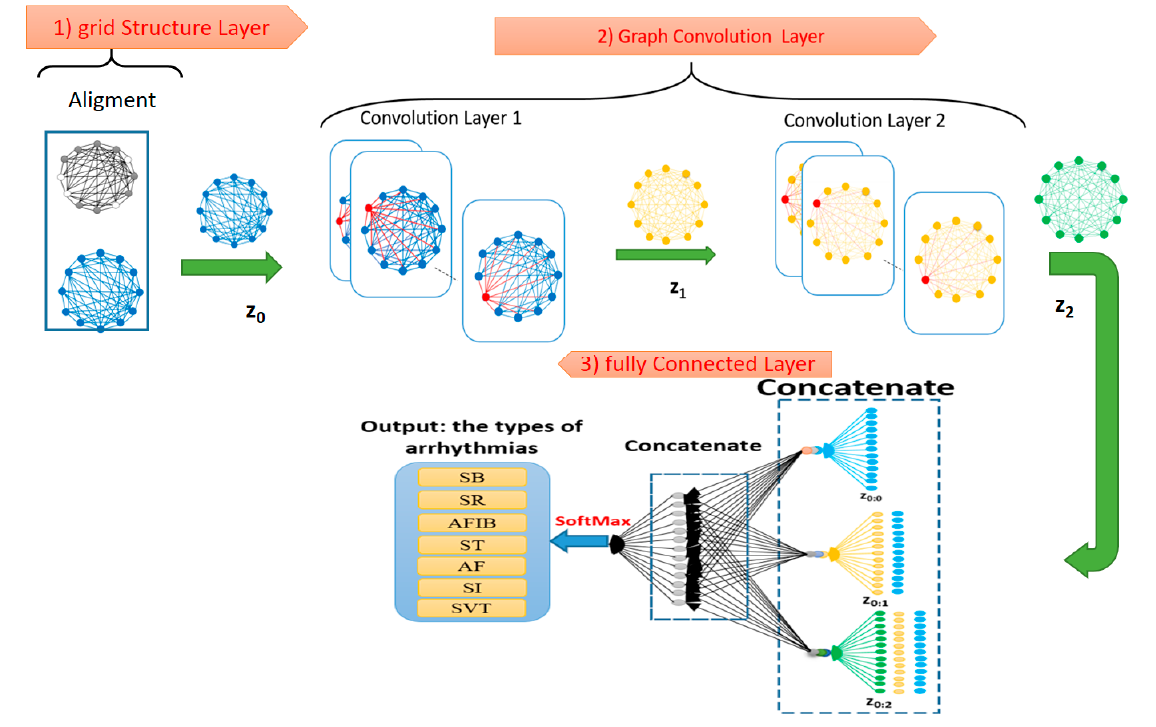
Figure 3. The network architecture for the GCN with two layers of convolution.